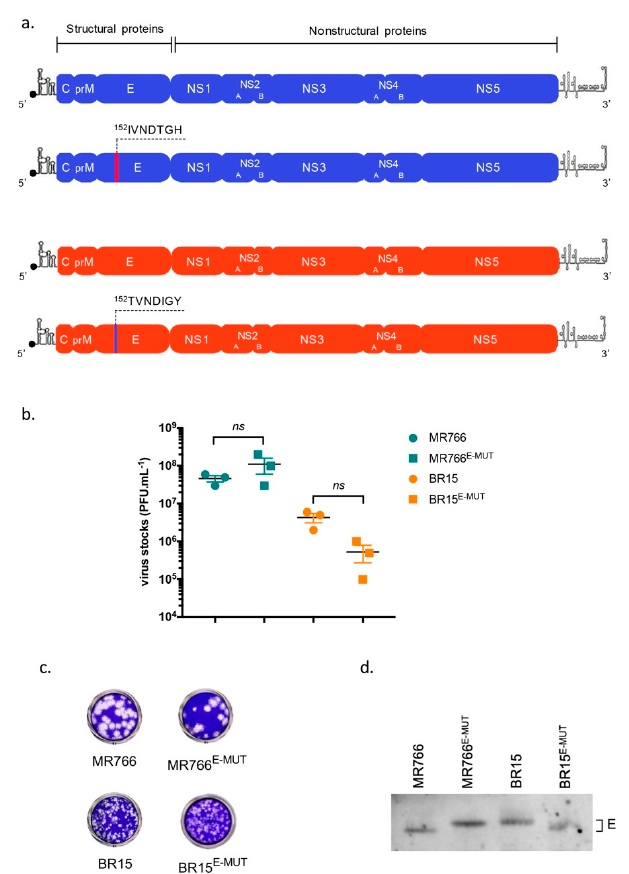
Figure 1. ZIKV mutant molecular clones. In ( a ), schematic representation of mutant viral clones BR15 E-MUT and MR766 E-MUT and their respective parental clones. In ( b ), histograms showing viral titres. Values represent means and standard errors of three independent experiments. In ( c ), examples of infectious plaques developed for BR15 E-MUT and MR766 E-MUT , and parental clones, after plaque-forming assay on Vero cells. In ( d ), Vero cells were infected with parental and mutant molecular clones (MR766 and BR15) at a MOI of 1. 24 h post-infection (hpi), cells were then lysed and subjected to an immunoblot, in non-reducing conditions. Anti-ZIKV EDIII immunoblot shows di ff erences of electrophoretic mobility associated with residue